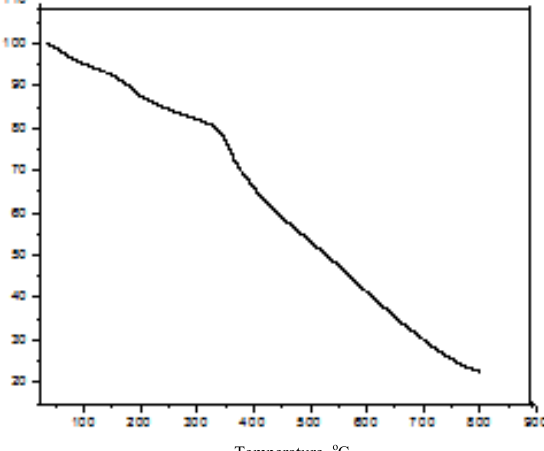
Figure 5. TGA curves of BF